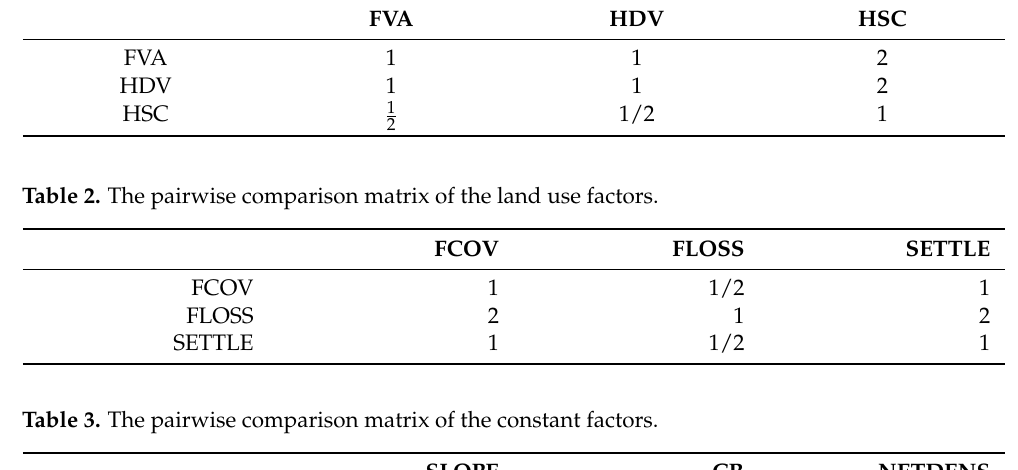
Table 1. The pairwise comparison matrix of the hydrological factors. FVA